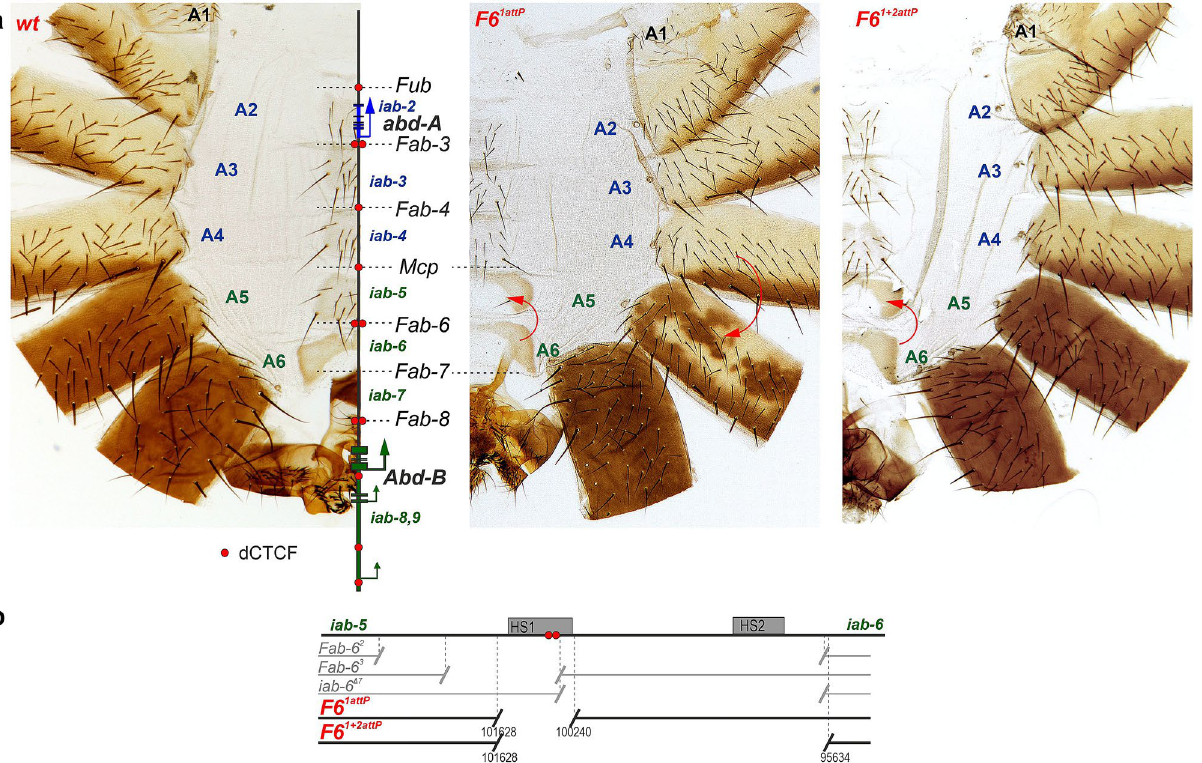
Figure 1. Deletions in the region of the Fab-6 boundary. ( a ) Morphology of the male abdominal segments in wild type ( wt ), F6 1attP and F6 1 + 2attP alleles. The organization of the abd-A and Abd-B regulatory regions in Bithorax complex is shown near wt abdominal segments. The abd-A (blue) and Abd-B (green) promoters are schematically demonstrated by arrows. The abdominal segments and iab -domains that provide their features are shown (more in the text). A7 and A8 are absent in wt adult males. A9 is a part of male genitals. The lines with colored circles mark characterized ( Fub , Mcp , Fab-6 , Fab-7 , and Fab-8 ) and predicted ( Fab-3 , and Fab-4 ) boundaries. The red circles indicate number of the CTCF binding sites in each boundary. F6 1attP and F6 1 + 2attP : the red arc arrows show the direction of segment transformation. ( b ) Schematic representation of deletions mapped in the region of the Fab-6 boundary. DNAse I hypersensitive sites (HS1 and HS2) are shown as gray boxes. Previously described deletions of the Fab-6 boundary 8 are indicated by breaks in the gray lines. The endpoints of F6 1attP and F6 1 + 2attP deletions used in the replacement experiments are indicated by breaks in the black lines. The coordinates of endpoints are according to the complete sequence of BX-C in SEQ89E numbering 61